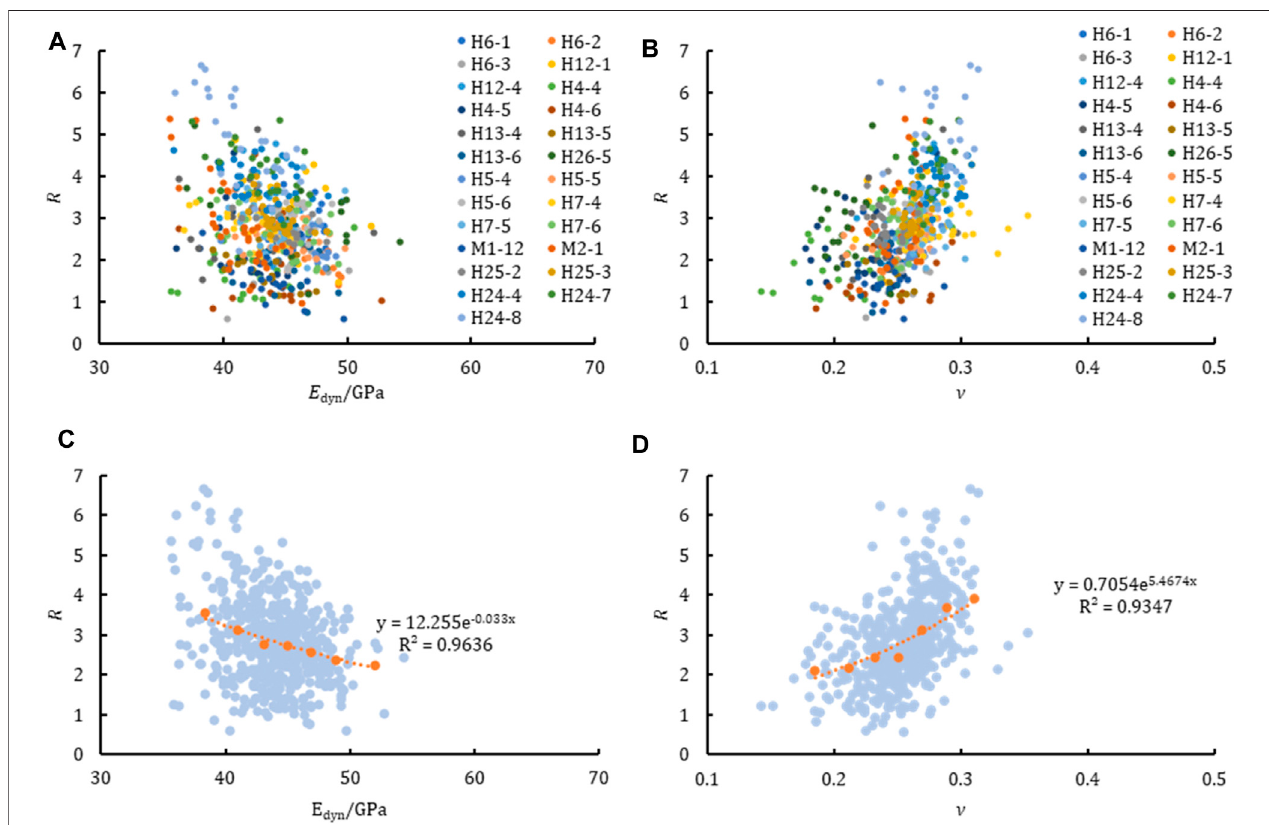
FIGURE 5 | Relationship among E dyn , ] of single segment and R of underground micro-seismic in Changning gas fi eld.